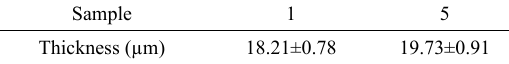
Table 2. Parameters for black chromium electrolytic deposition Samples